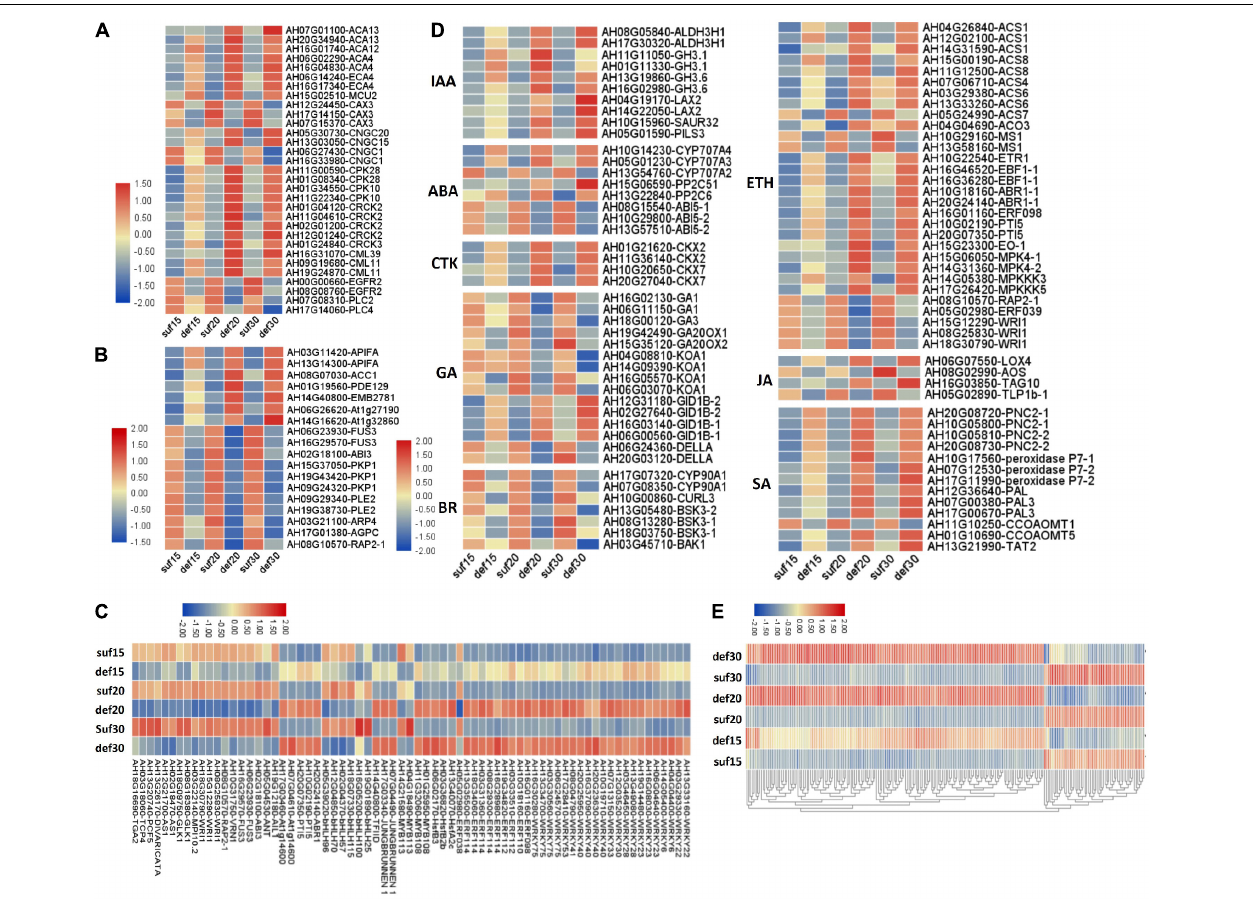
FIGURE 4 | Relative expression changes of important differential expression genes and microarray validation of expression profiles of identified DEGs under deficiency calcium. (A) Calcium signaling pathway-related genes. (B) Embryo development related genes. (C) Transcription factors. (D) Plant hormone related genes. IAA, indole-3-acetic acid; ABA, abscisic acid; CTK, cytokinin; GA, gibberellin; BR, brassinosteroid; ETH, ethylene; JA, jasmonic acid; SA, salicylic acid. (E) Parts of common DEGs at the three stages. The expression level was calculated using log 2 (FPKM +